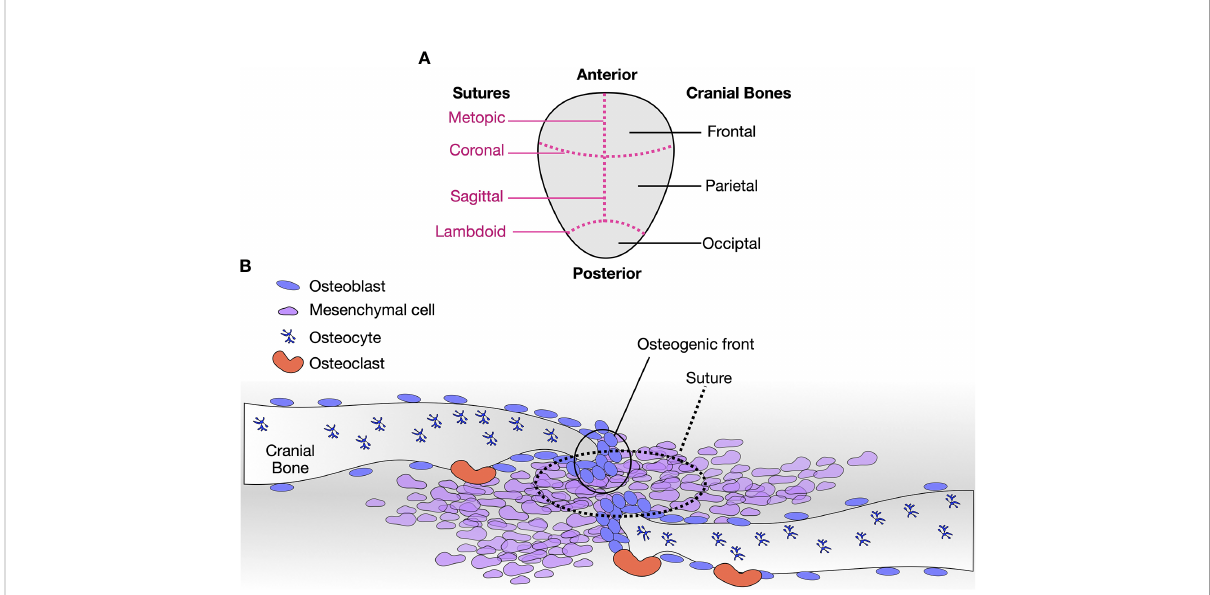
FIGURE 2 Cranial sutures are paradigms to study osteoblast differentiation, remodeling, and regeneration. (A) Diagram of a human calvaria, with respective cranial bones (right, black) and sutures (left, magenta, dashed lines). (B) Diagram of a suture. Osteoblasts, osteocytes, osteoclasts, and mesenchymal cells are indicated. The tip of each cranial plate is a region of active osteoblasts bone deposits. Osteoblasts lining cells are positioned away from the fronts and along the bone. Osteocytes are embedded in the bone matrix, and osteoclasts resorb bone. At the sutures, pluripotent mesenchymal cells self-renew and eventually enter osteoblastic differentiation to contribute to the osteogenic fronts. As observed with craniosynostosis, minor molecular disturbances at the sutures lead to severe